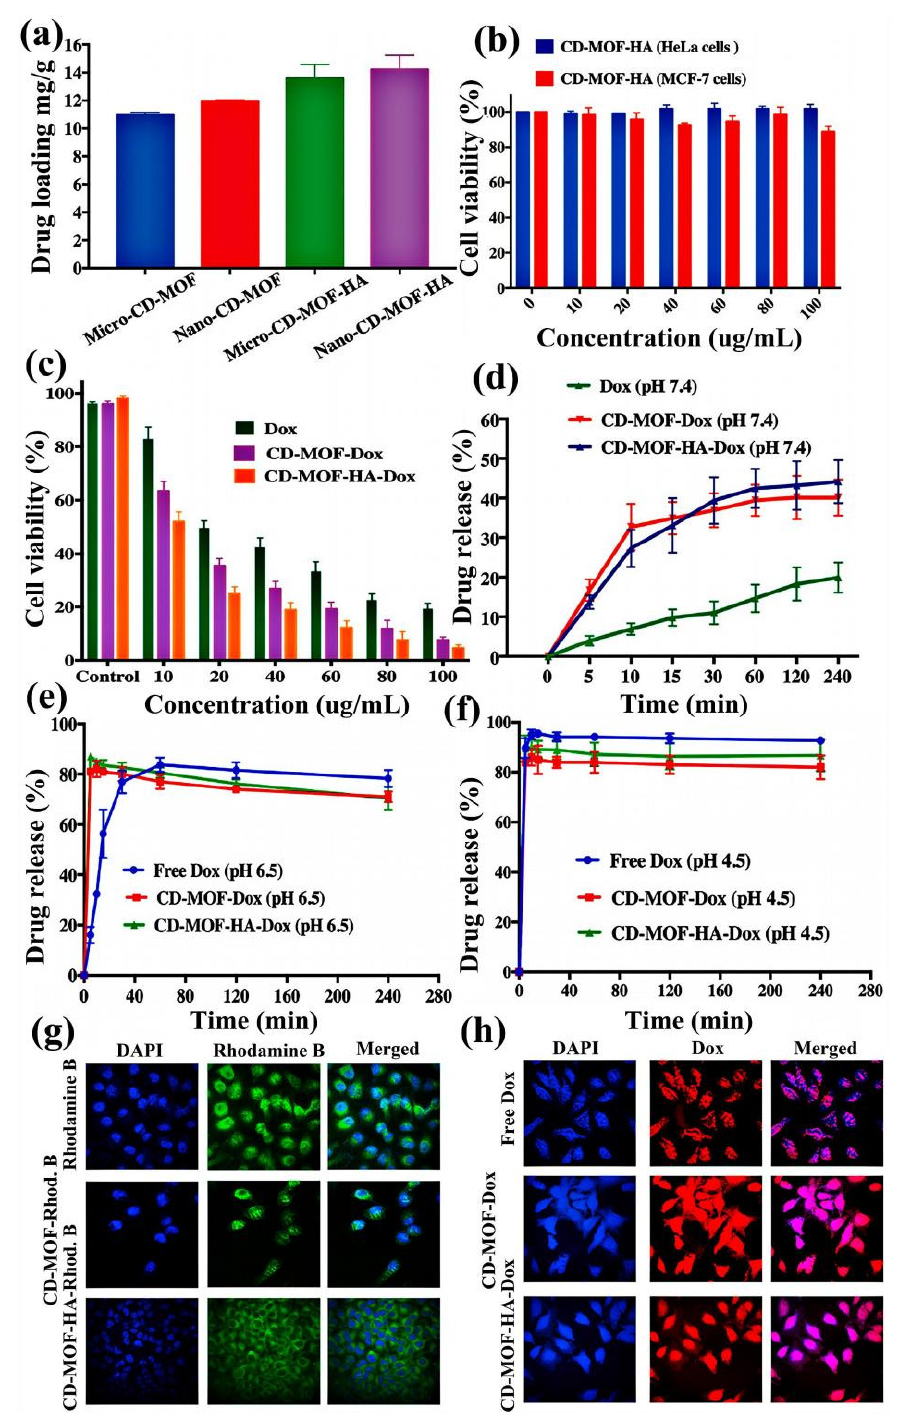
Figure 9. The bioapplication of CD-MOF-based carriers. Reproduced with permission from Ref. [81], copyright (2022) Elsevier.